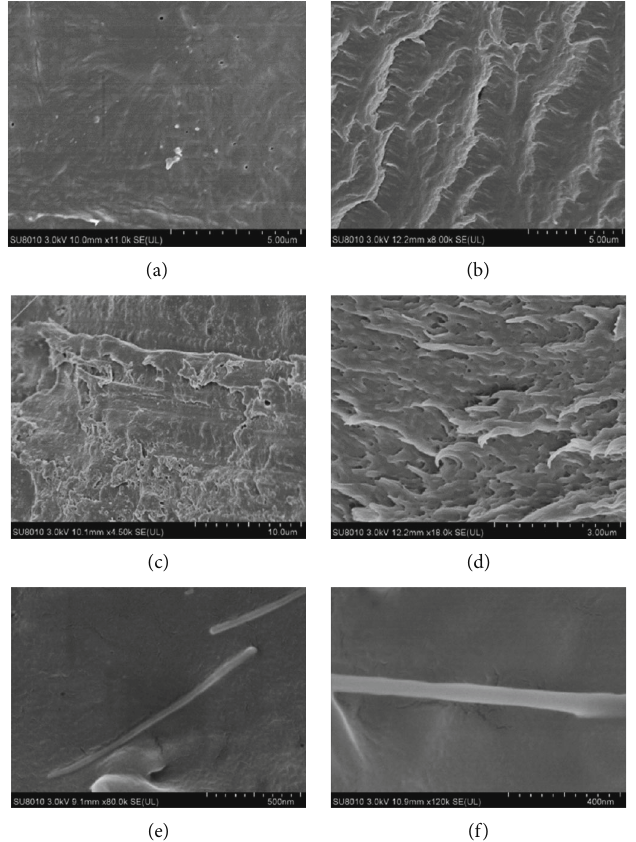
Figure 5: SEM images of PLA and PLA/2.5 wt% BCNW composites: (a) PLA surface, (b) PLA fractural surface, (c) PLA/BCNW composites surface, (d) PLA/BCNW composites fractural surface, and (e) and (f) morphology of BCNW in PLA matrix. (Reproduced with permission from Elsevier, license number: 5195441102270)